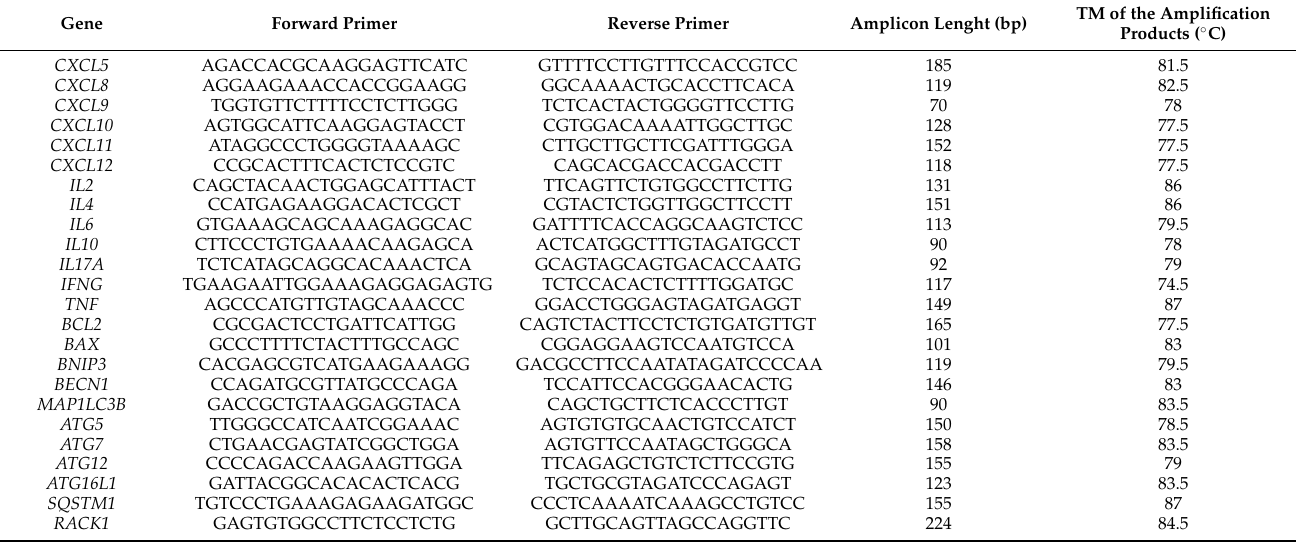
Table 2. Primers used for qPCR in the